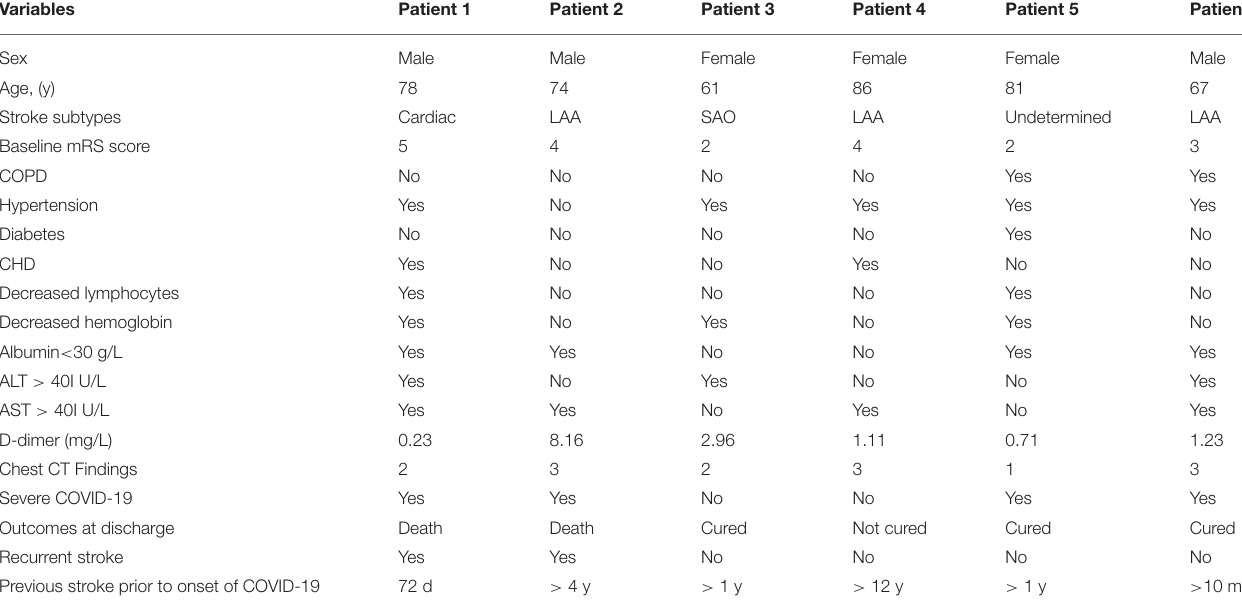
TABLE 3 | Characteristics and outcome of patients with previous stroke ( n =